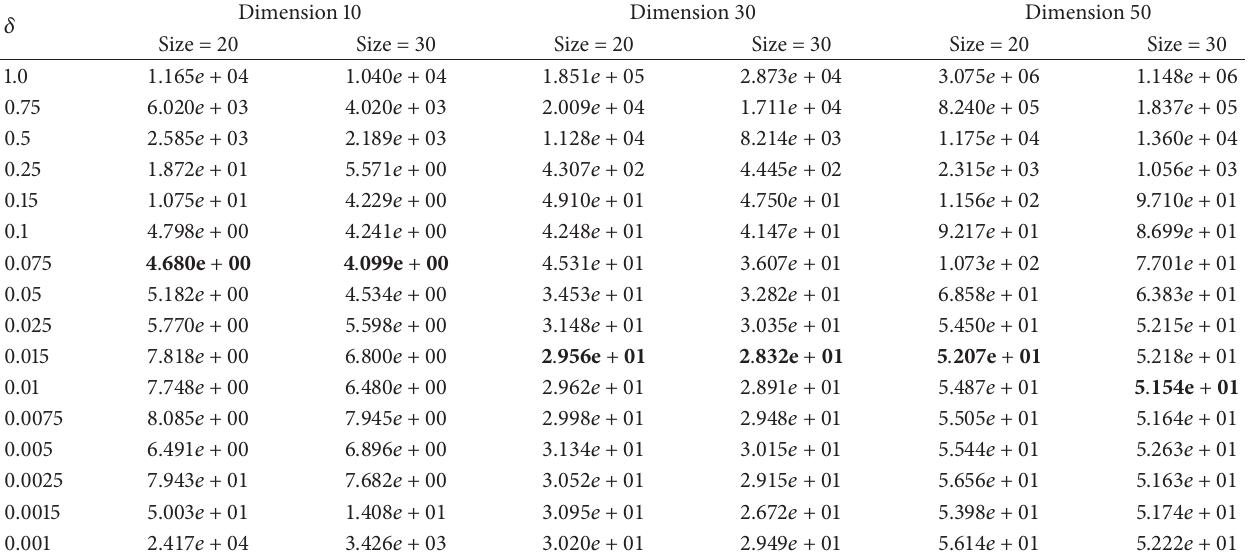
Table 11: Different values of parameter 𝛿 and respective mean best fitness for Rosenbrock test problem.